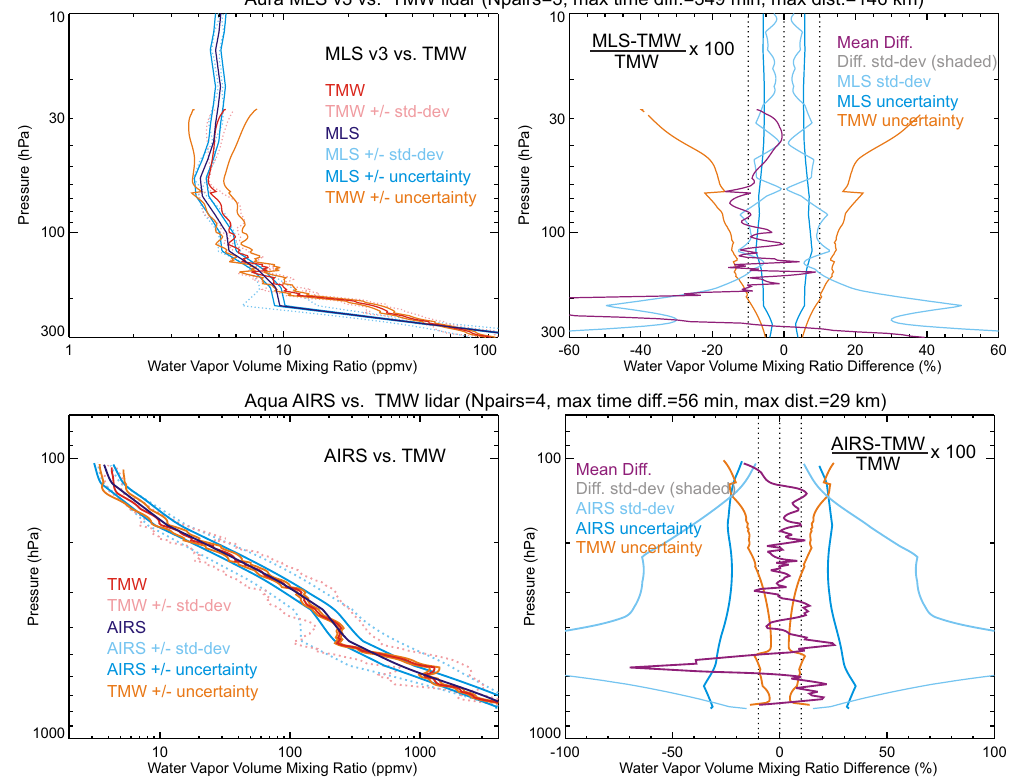
Fig. 14. Top: averaged mixing ratio profiles (left) calculated from the 3 coincident profiles measured in the UTLS by the TMW lidar and Aura-MLS during MOHAVE-2009, and their difference (right). Bottom: averaged mixing ratio profiles (left) calculated from the 4 simultaneous profiles measured by the TMW lidar and Aqua-AIRS during MOHAVE-2009, and their difference (right). Aura MLS (version 3), and their difference (right). As we